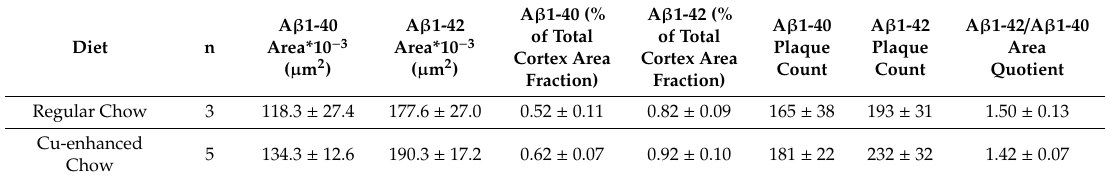
Table 3. Cu-enhanced diets exacerbated brain A β amyloidosis in APP / PS1 transgenic mice- IHC analysis results.